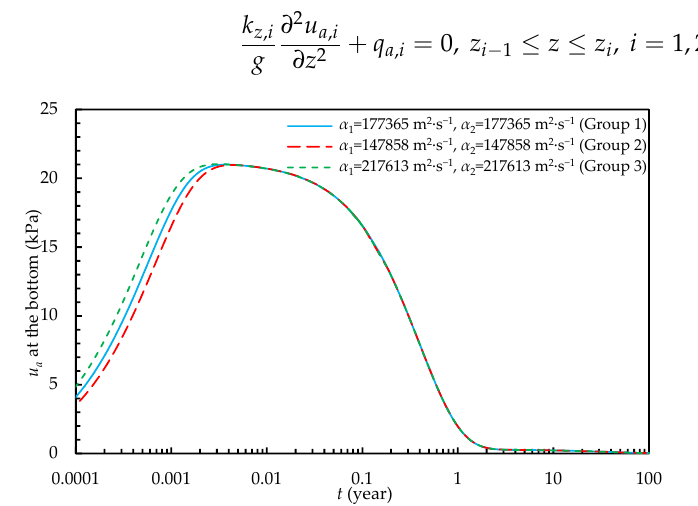
Figure 3. Effect of the parameter α on the gas pressure.